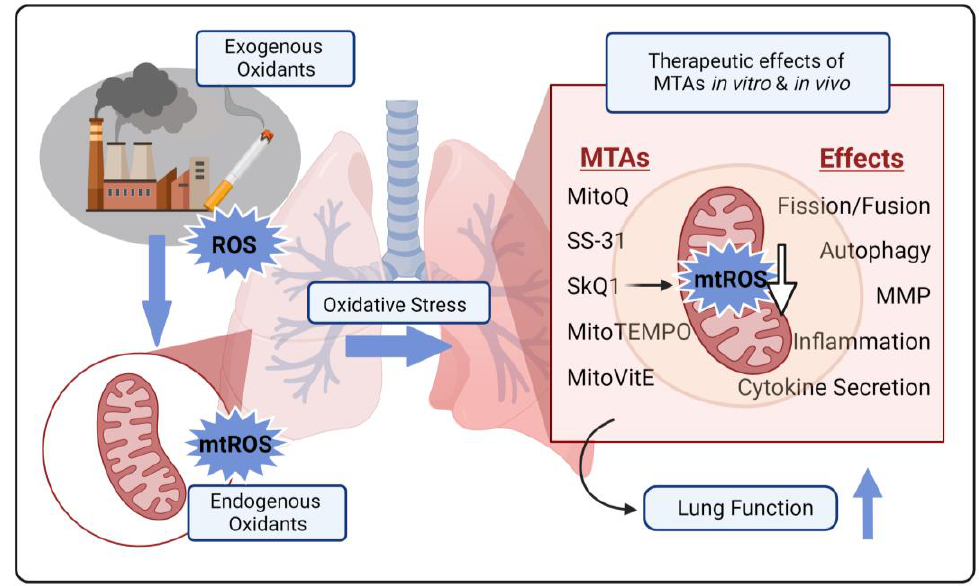
Figure 1. Therapeutic effects of mitochondria-targeted antioxidants in COPD. Endogenous exposure to oxidants triggers endogenous mtROS production in COPD. In vitro studies using cells from COPD patients, or in response to cigarette smoke (CS) exposure, have reported protective effects on mitochondrial ROS levels, fission and fusion, mitophagy, MMP, as well as inflammation and cytokine secretion. Abbreviations: ROS: reactive oxygen species; mtROS: mitochondrial ROS; MMP: mitochondrial membrane potential. Table 2. Mitochondria-targeted antioxidants in clinical trials for chronic lung